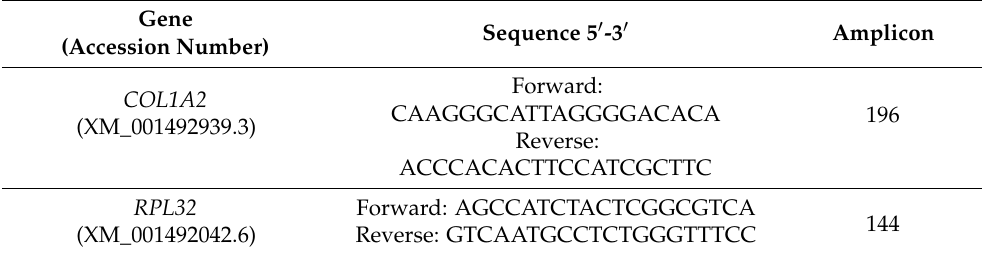
Table 3. Sequences of primers used for quantitative real-time polymerase chain reaction